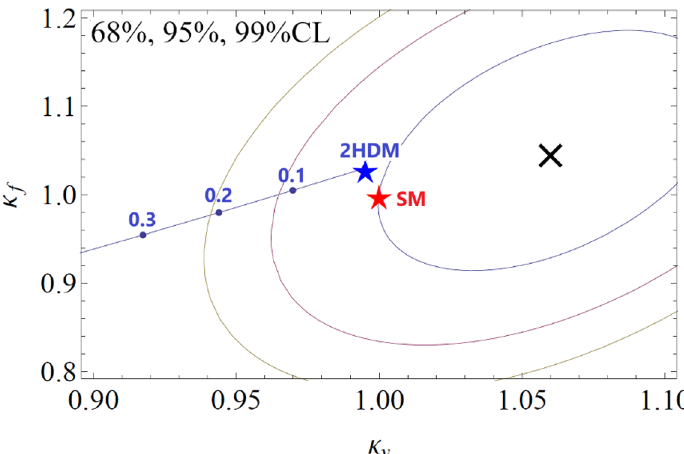
Figure 2 . The (cid:12)t of the Higgs coupling strengths to the gauge bosons ( (cid:20) V ) and fermions ( (cid:20) f ) obtained by the ATLAS [64] from the 13 TeV LHC data. The cross is the observed central value. The circles from inside out represent the 68%, 95%, and 99% CL respectively. The red star shows the SM value (1 ; 1). The blue star in the predicted value of the 2HDM benchmark of section 5 with (cid:24) = 0. Along the line, we show the predictions for the same benchmark with di(cid:11)erent (cid:24) from 0 to